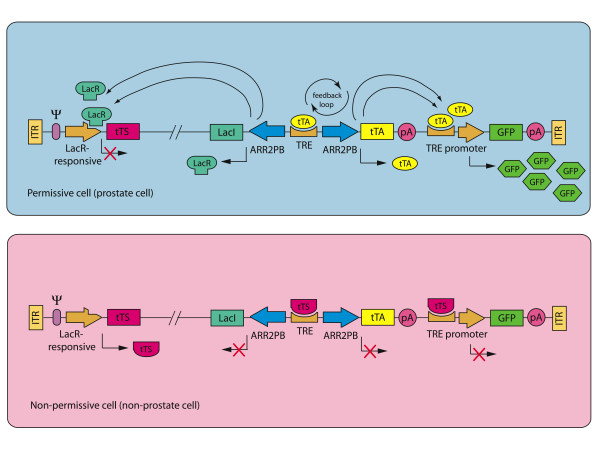
Mechanism of action of the Ad/GFPDiSTRES vector. Mechanism of action of the Ad/GFPDiSTRES vector when transduced into a prostate cell (top panel). We hypothesize that the following sequence of events would occur in the prostate cell: (1) Both the tTA and the LacI genes would be induced, as a result of activation of the prostate specific TRE-ARR2PB promoters that drive the expressions of these genes; (2) Expression of tTA would then lead to transcriptional activation of the gene of interest (e.g., GFP), through binding of tTA to the TRE promoter; (3) The tTA protein would also bind to the TRE within its own TRE-ARR2PB promoter, thereby activating further transcription of itself and therefore establishing a positive feedback amplification loop of tTA expression; (4) Meanwhile, the LacR protein would bind to the LacR-responsive promoter of the tTS gene, thereby leading to suppression of tTS gene transcription; and (5) Finally, the tTA-driven amplification loop would lead to further expression of both the gene of interest and the LacR (and subsequently further repress the tTS). Mechanism of action in non-prostate cells (bottom panel). In the non-prostate cell, we propose the following scenario: (1) Because the TRE-ARR2PB promoter is prostate-specific, neither the tTA nor the LacR proteins would be expressed; (2) In the absence of the LacR protein, the LacR-responsive promoter acts essentially like its constitutively active parental promoter (the CMV promoter). As a result, the tTS gene is now actively transcribed; and (3) Expression of the tTS protein would then lead to the transcriptional silencing of all TRE-regulated promoters, and therefore, the gene of interest (GFP), tTA and LacR would all be suppressed upon binding of the tTS to the TRE's within their respective promoters. Note: Tetracycline and/or doxycycline are not added to this system. Adding these drugs would act to negate the effects of the differential regulation of tTA versus tTS. The result would be basal expression of GFP in both cell types, and therefore, a loss in prostate-specificity.